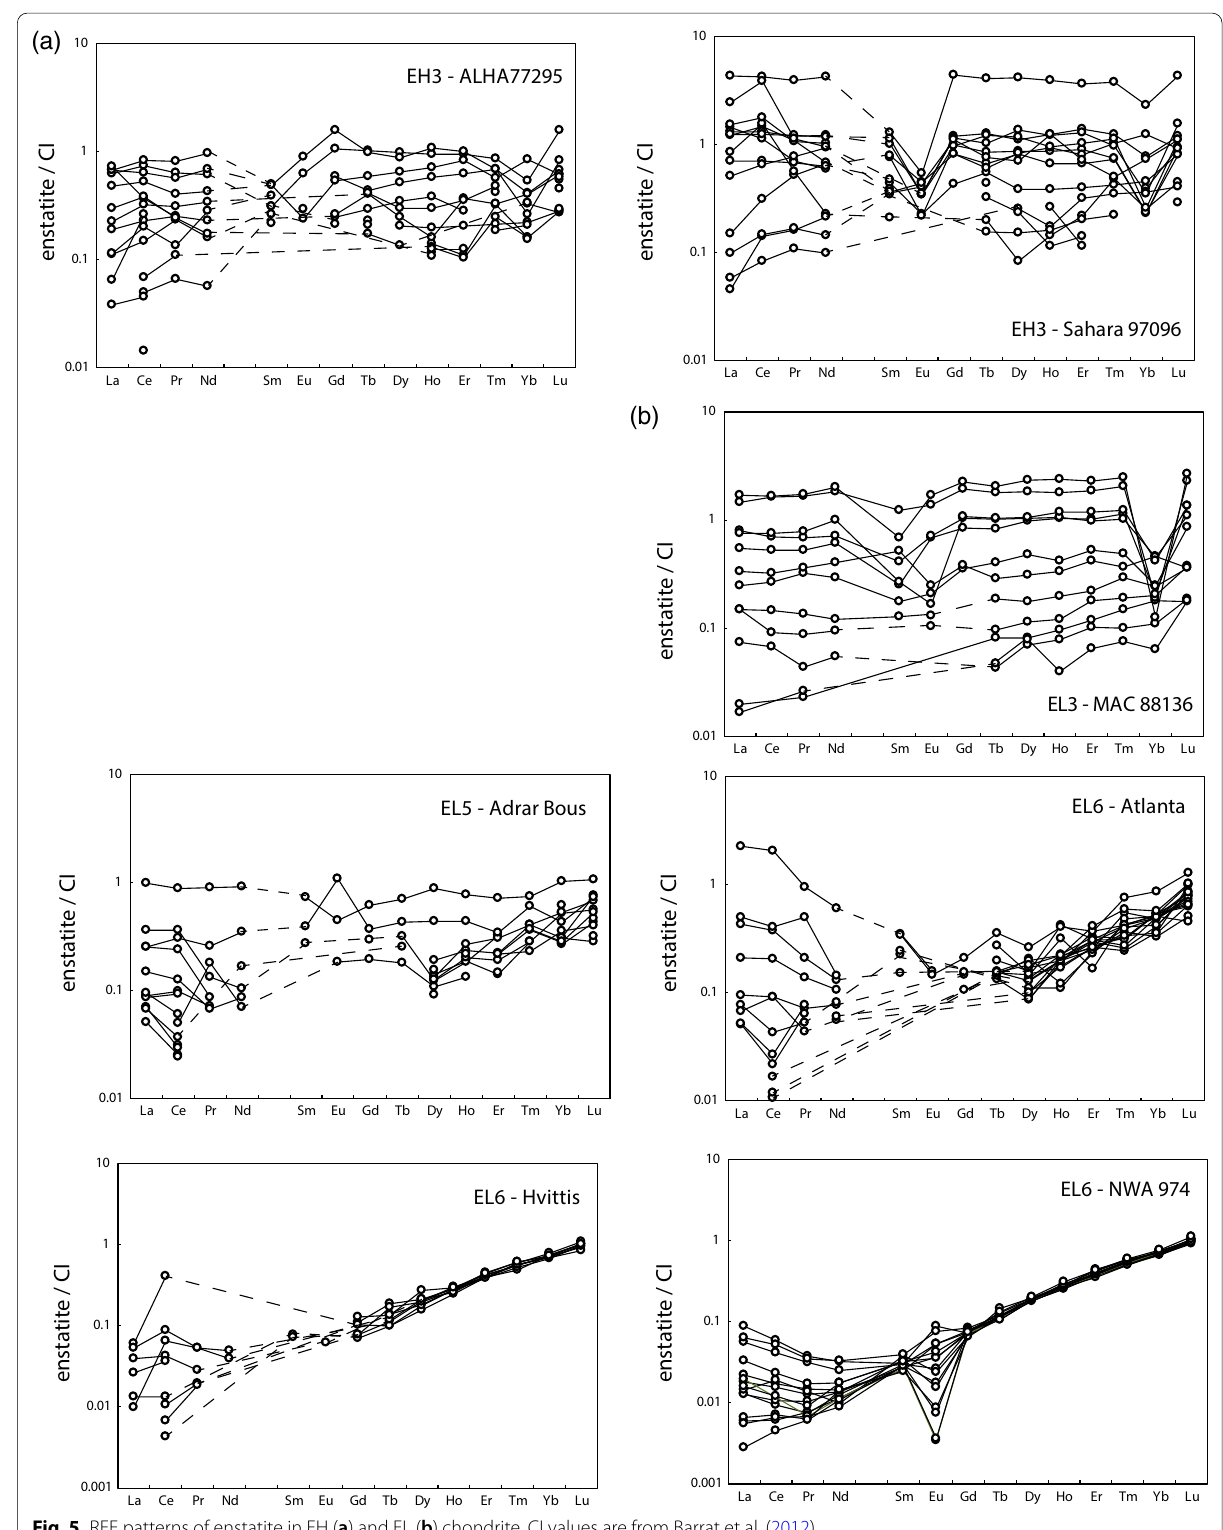
Fig. 5 REE patterns of enstatite in EH ( a ) and EL ( b ) chondrite. CI values are from Barrat et al.